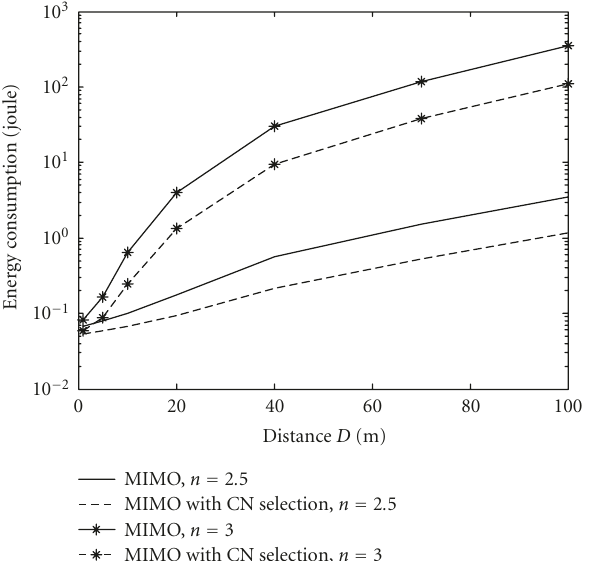
Figure 10: E ff ect of CN algorithm on network’s lifetime; n = 2 . 5, M =